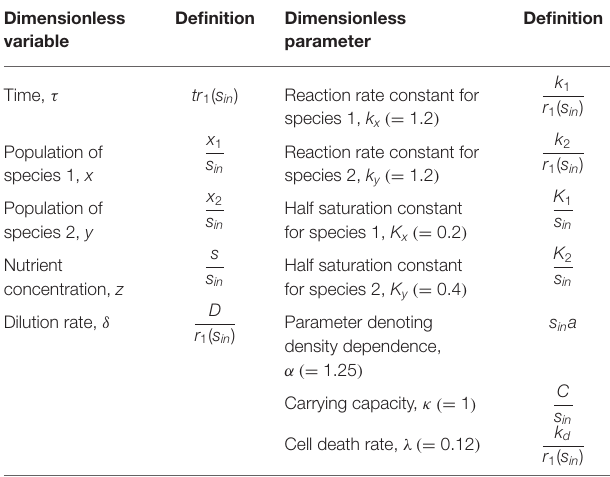
TABLE 1 | Definitions of dimensionless variables and parameters contained in the